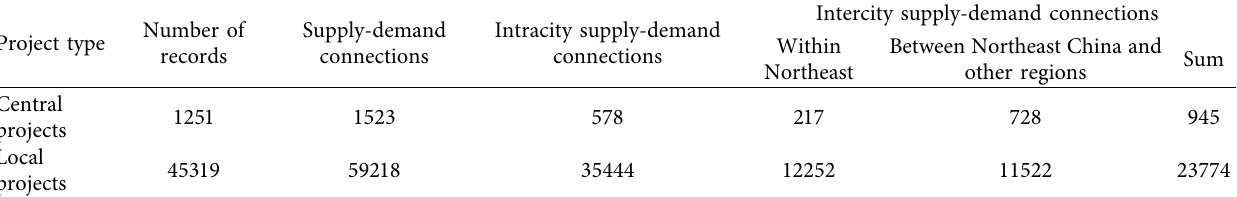
Table 1: Summary statistics of the GPA supply-demand